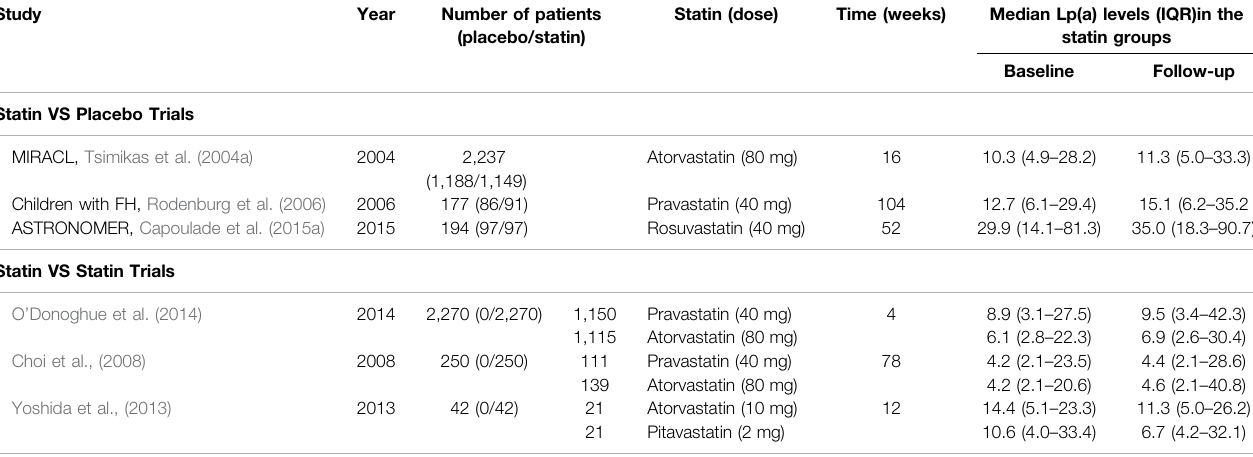
TABLE 1 | Characteristics of trials which statins signi fi cantly increase plasma Lp(a) levels. Study Year Time (weeks) Median Lp(a) levels (IQR)in the